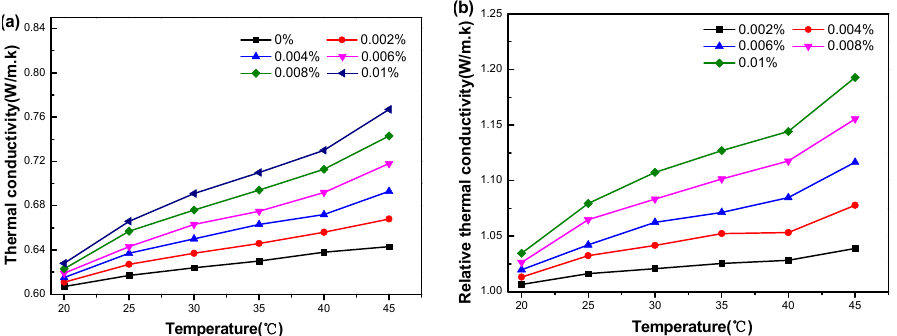
Figure 5. Thermal conductivity of GO–water nanofluid versus temperature. ( a ): absolute, ( b ): relative to water.